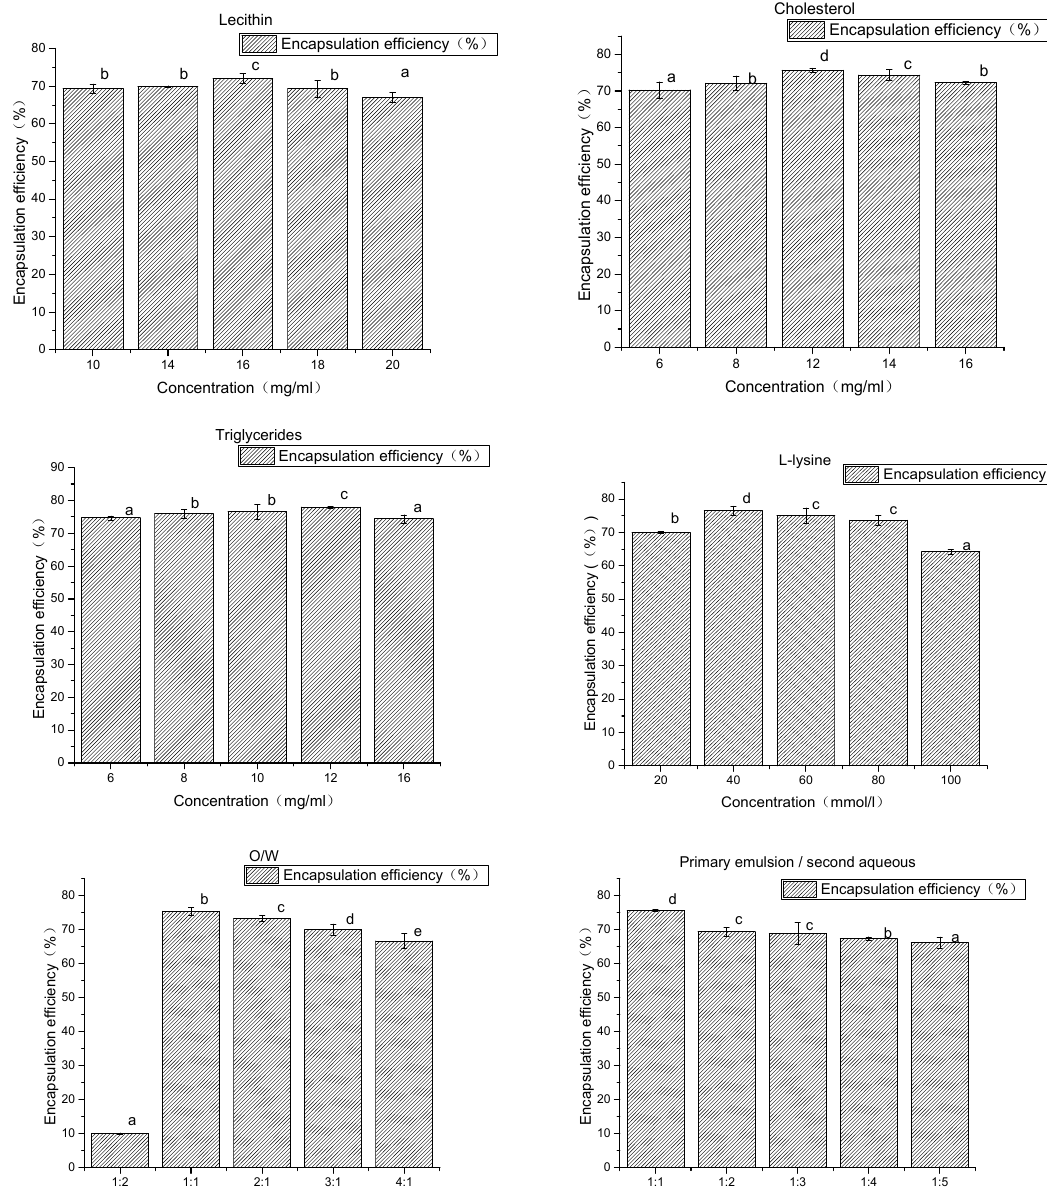
Figure 2. The results of the prescription and artwork. a–e Different superscript letters in the same series indicate statistical difference ( p < 0.05).